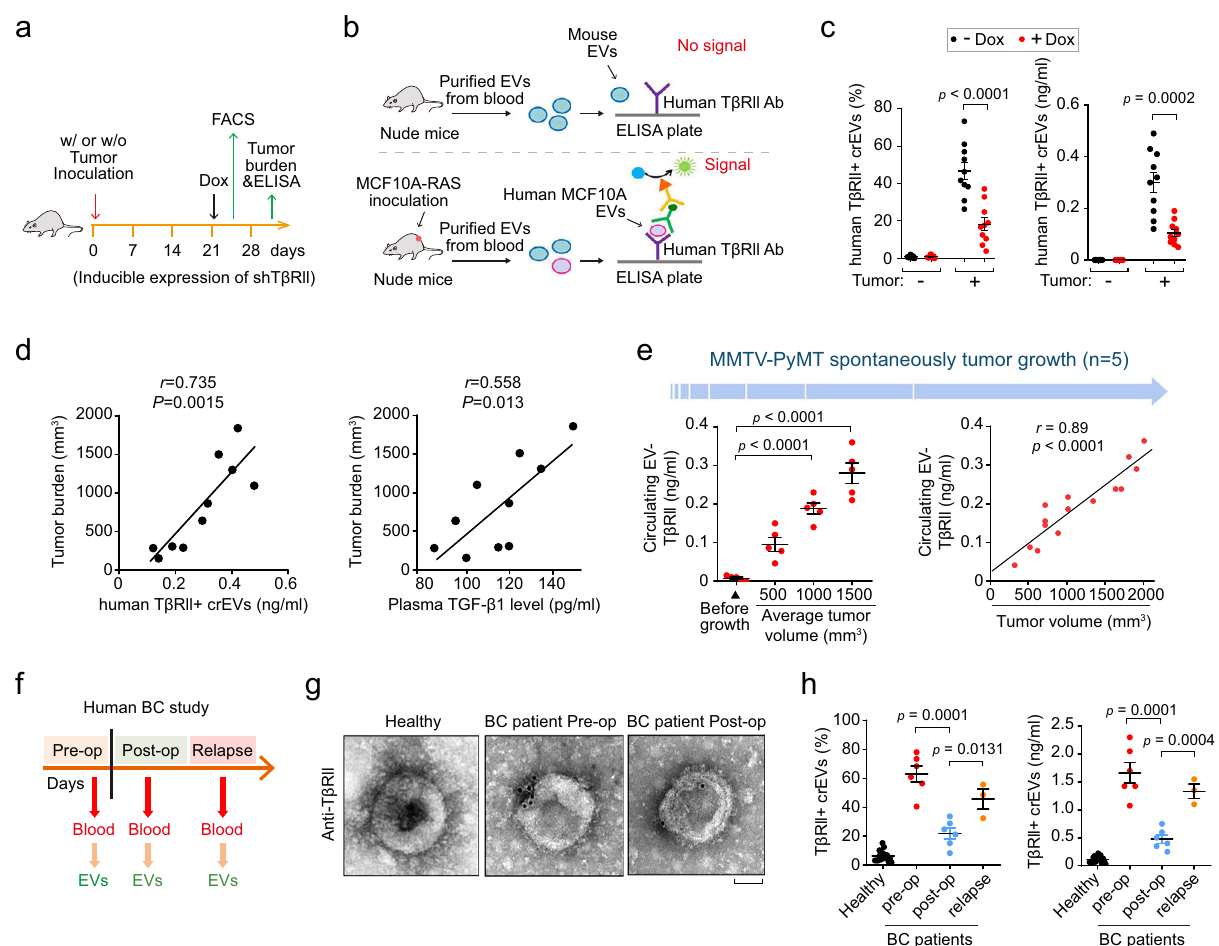
Fig. 2 The amounts of T β RII + crEVs positively correlate with tumor burden. a Experimental analysis in vivo: mice were not inoculated ( − ) or were given subcutaneous inoculation ( + ) of MCF10A-RAS cells (5 × 10 5 cells per mouse) expressing control shRNA or doxycycline-inducible shRNA targeting T β RII (shT β RII) and tumors were grown for 3 weeks, followed by the administration of doxycycline (Dox). 3 d later, mice were euthanized for further analysis ( n = 10 mice per group). b Schematic of ELISA of human T β RII on EVs in plasma samples from mice with human breast cancer xenograft. c FACS analysis (left) of the percentage of T β RII + crEVs and ELISA (right) of T β RII on crEVs in plasma samples from mice ( n = 10 mice per group). d Pearson correlation between the T β RII + crEVs or TGF- β 1 in plasma and the tumor burden from the control group mice without Dox administration ( n = 10 mice per group). e Quanti fi cation of circulating EV-T β RII at the indicated tumor volume (left panel). Pearson correlation between the circulating EV-T β RII in plasma and tumor burden from mice was shown right ( n = 5 mice per group). f Schematic diagram of longitudinal blood collection pre-operatively, post-operatively or relapse. g Electron microscopy images of EVs secreted from healthy donors, patients with pre- and post-operatively breast cancer. Scale bars, 50 nm. h FACS (left) and ELISA (right) of T β RII + crEVs in plasma samples from patients with breast cancer pre-operation ( n = 6 patients), post-operation ( n = 6 patients), relapse ( n = 3 patients) and healthy donors ( n = 20 samples). * p < 0.05 (two-tailed Student ’ s t test ( c , e (left), h ) or two-way ANOVA ( d , e (right))). Data are analyzed of three independent experiments and shown as mean ± SD ( c , e (left), h ). Source data are provided as a Source Data fi